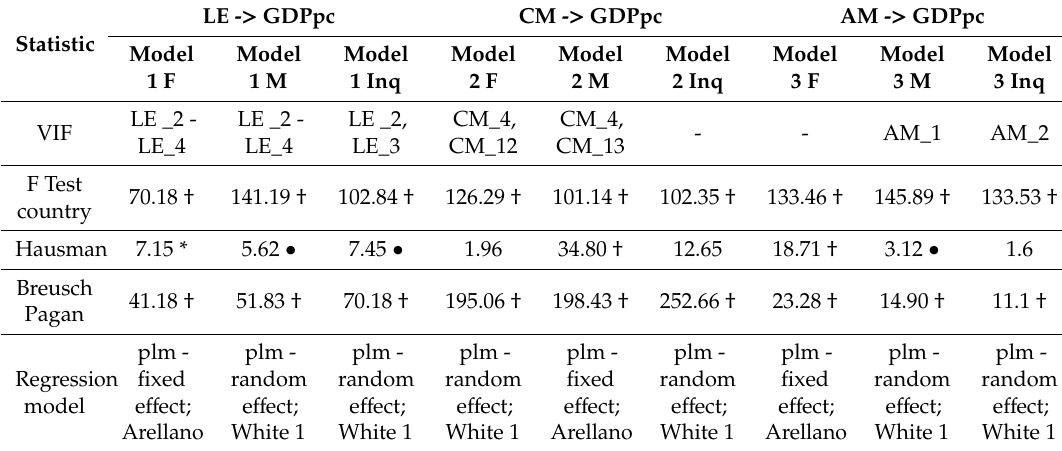
Table 4. Assumptions for the regression